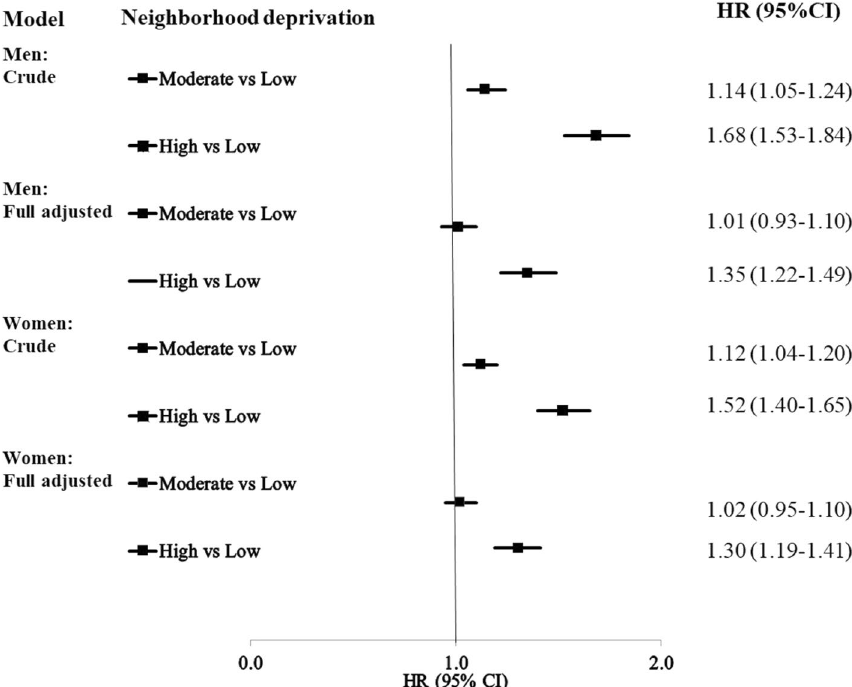
Figure 2. Hazard ratios (HR) and 95% confidence intervals (CI) for fatal CHD in patients with bipolar disorder. The full model is adjusted for all the individual level sociodemographic variables and comorbidities. CHD Coronary heart disease, HR Hazard ratio, CI Confidence